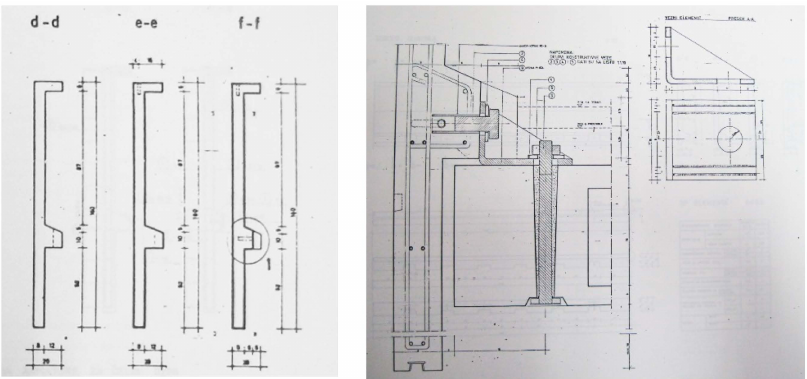
Figure 10. Connection between edge girder and loggia parapet (EG—PW demountable joint), (source: original drawing sheet from Historical Archives of New Belgrade, 1965).